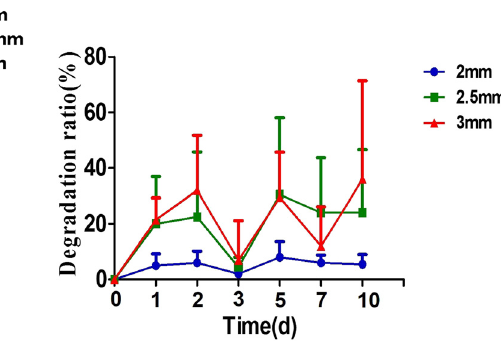
Figure 4: Swelling ratio test of GG/ST sca ff old with various printing gap. * p < 0.05 by one - way ANOVA test. Figure 5: Degradation experiment of GG/ST sca ff